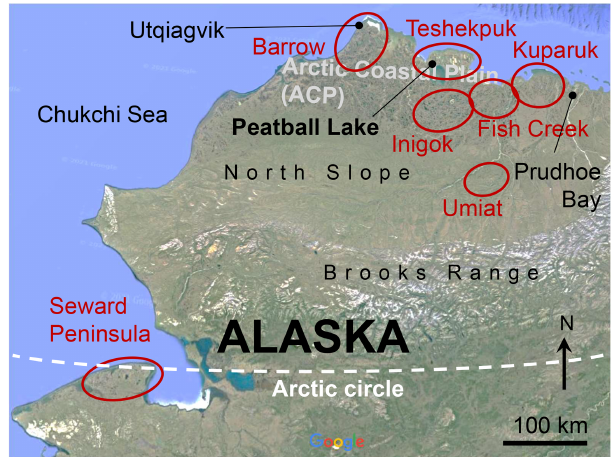
Figure 2. Lake bathymetry models for a thermokarst lake and the talik underneath based on the quasi-steady state. (a) The lake bathymetry is proportional to the talik geometry with uniform ice distribution. (b) The lake bathymetry tends to have a flat bottom due to the widespread ice-rich layer near the surface.